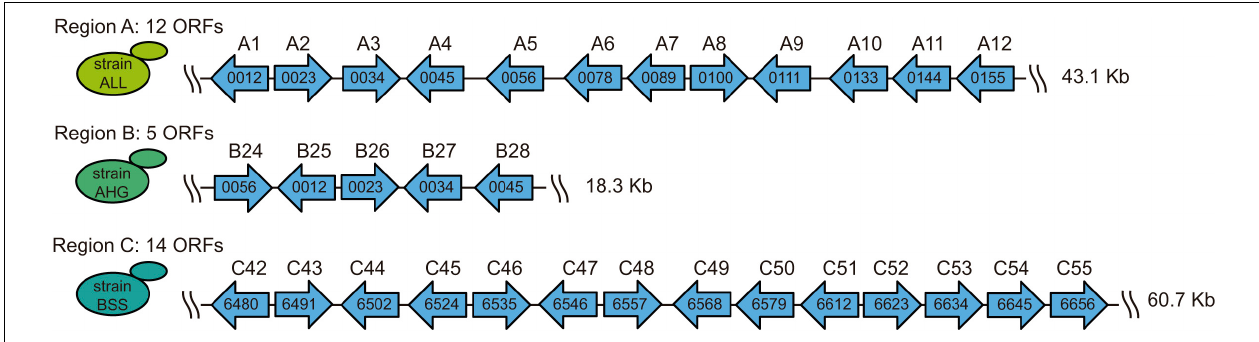
FIGURE 1 | Genetic structure of the horizontally acquired regions. The horizontally acquired regions A, B, and C are present in a single copy per genome in the ALL, AHG, and BSS strains, respectively. The ORFs and their orientation within each region are indicated by arrows. The name inside each ORF corresponds to the annotation according to the genome information of the EC1118 strain. The name above each ORF represents the order in the horizontally acquired region according to the “1002 yeast genomes project” information.